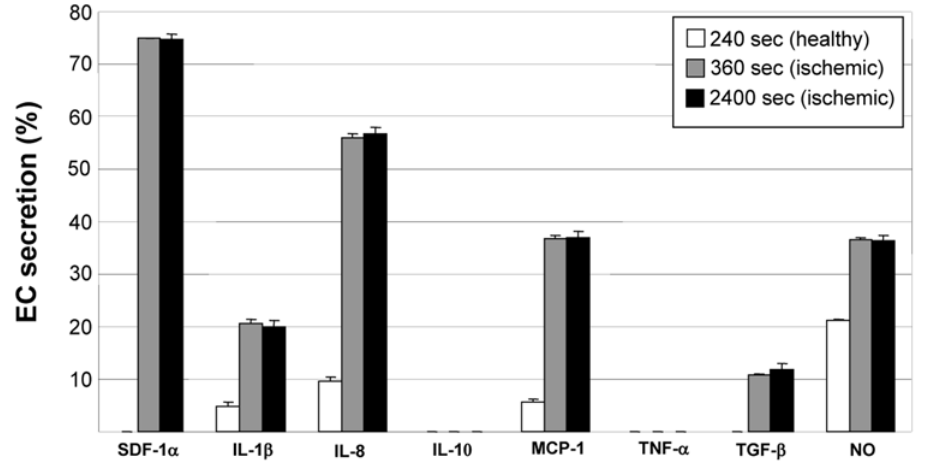
Figure 3. The ABM reproduced increased secretion of inflammatory chemokines and cytokines by simulated endothelial cells. Baseline secretion was relatively low and stable prior to injury at time=300. Following injury (time=360), secretion markedly increased and remained relatively unchanged for duration. Changes in secretion of chemokines and cytokines are the aggregate result of cell interactions with each other and their environment. SDF-1 a secretion was pre-programmed and not a result of simulated injury, and no rules existed for the secretion of IL-10 or TNF- a by endothelial cells. Reported are mean values + standard deviation (n=5).